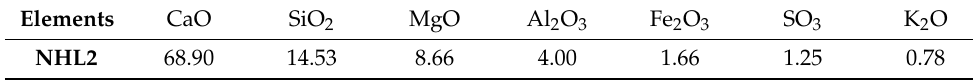
Table 1. Chemical composition of NHL2